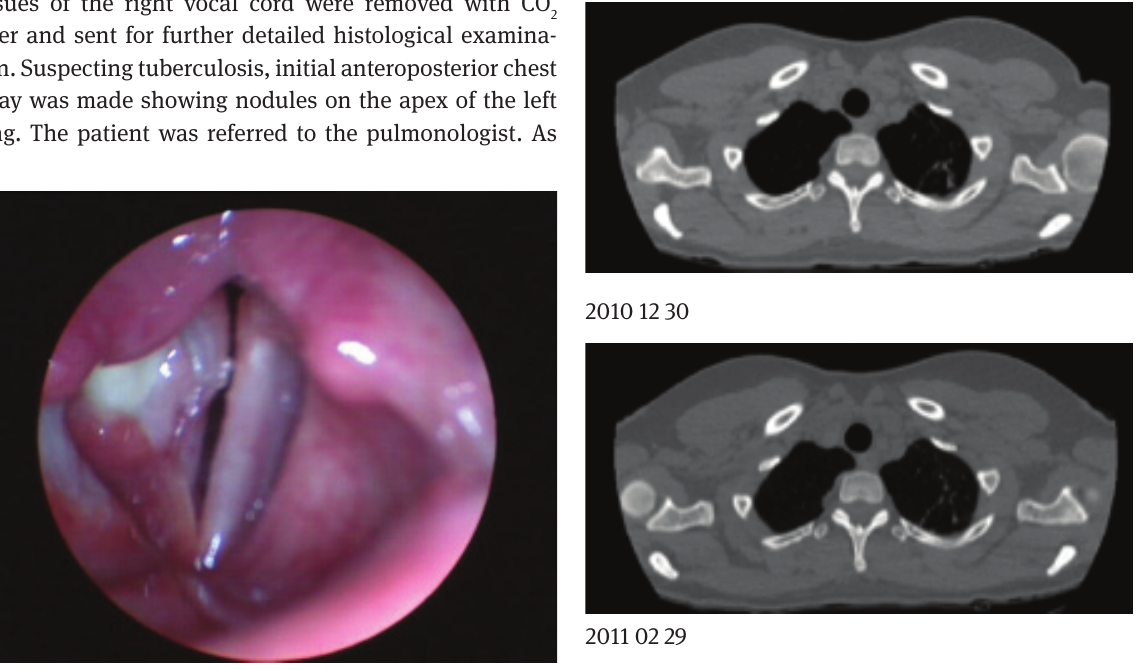
Figure 1: Videostroboscopy before the surgery: granuloma on 2 nd and 3 rd thirds of the right vocal cord.